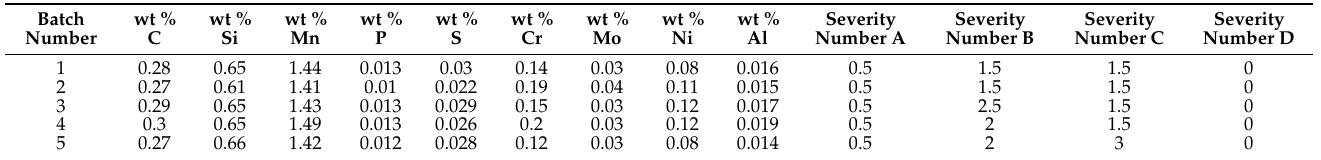
Table 3. The chemical composition of five successively cast batches of 30MnVS6 and severity numbers for inclusions determined according to standard ASTM E45, method A.